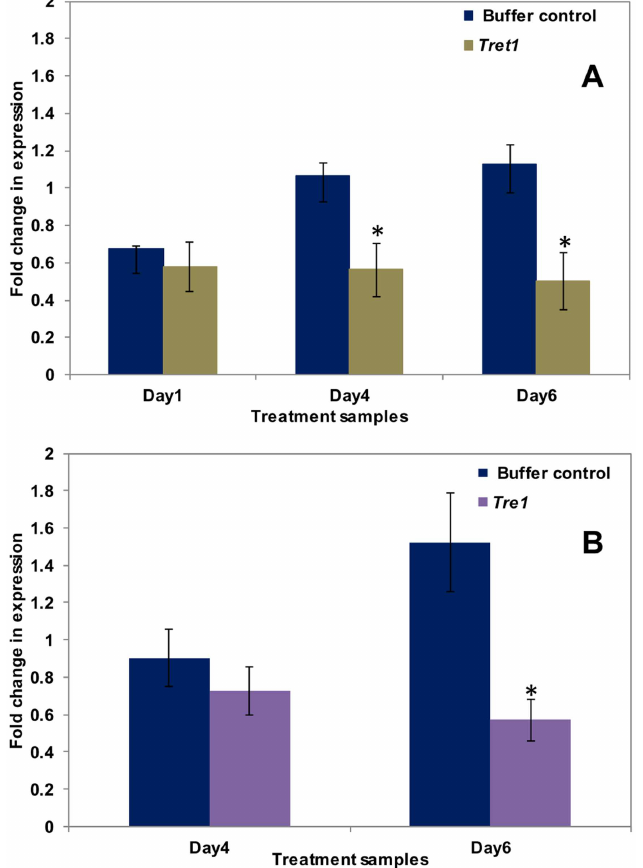
Fig 3. Results of qPCR analysis for gene targets involved in sugar metabolism and transport. The qPCR amplification of expressedwhitefly genes involvedin sugar metabolismand transport, post-RNAi knock down. (A) Comparisonof fold-change expressionof Trehalosetransporter 1 ( Tret1 ) for whitefliestreated with 30 μ g/mlof Tret1 dsRNA (tan), and the buffer control (blue bars) on day one, four, and six, post-treatment (x- axis). (B) Comparison of fold-changein expressionof Trehalase1 ( Tre1 ) for whitefliestreated with 30 μ g/mlof Tre1 dsRNA (purple) on day four and six (x-axis). Sugar metabolismgenes were ~ 30–40%down regulated. The “asterisk” indicatesa significant p- value( < 0.05) ( t -test).